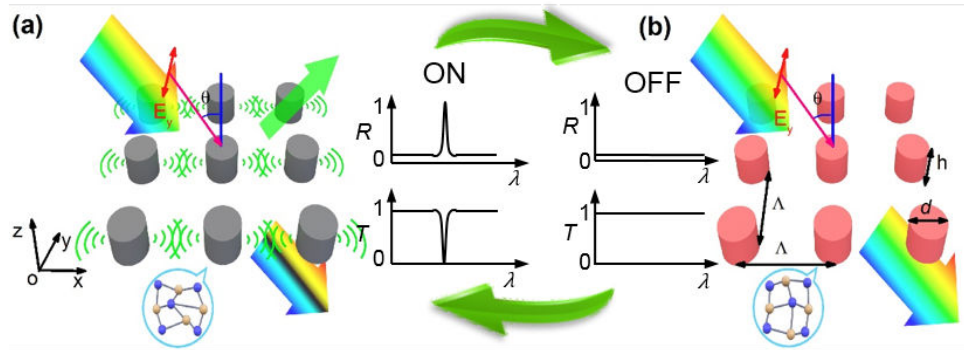
Figure 1. Schematics of the actively switchable ED-SLR in GST nanorod array under oblique incidence with TE polarization. ( a ) When GST is in the amorphous state, the ED-SLR is excited, resulting in extremely narrow bandpass filtering in reflection and bandstop filtering in transmission. ( b ) When GST is in a semi-crystalline state, the ED-SLR and the narrowband reflection/transmission filtering are switched